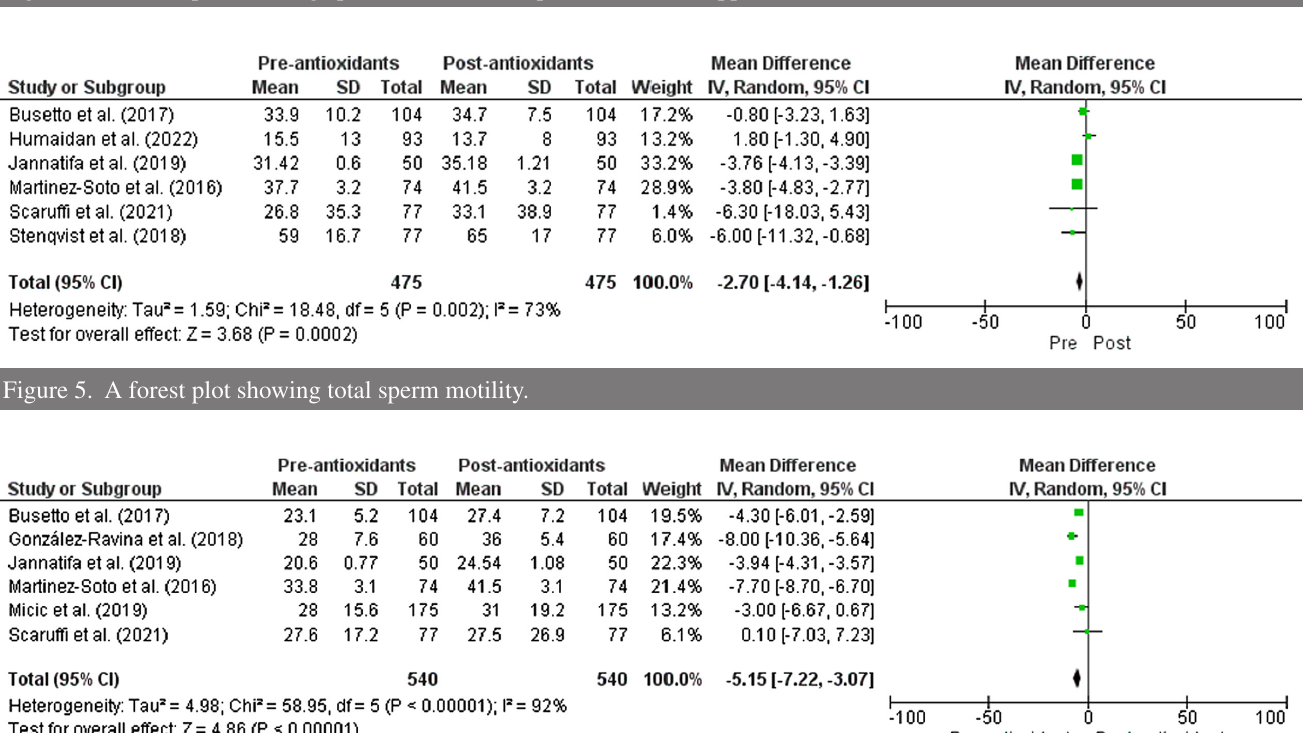
Figure 4. A forest plot showing sperm concentration pre-antioxidant supplementation.